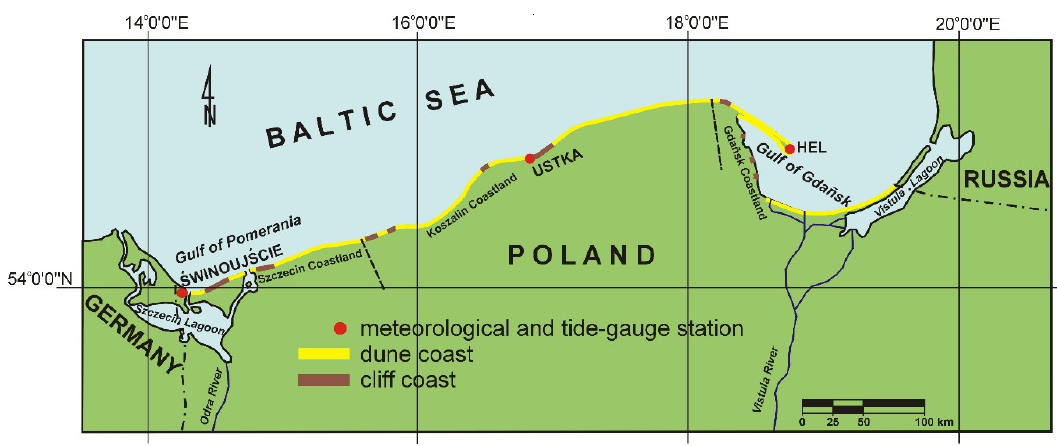
Figure 1. Area of research and location of measurement stations in the Polish Baltic coastal zone.